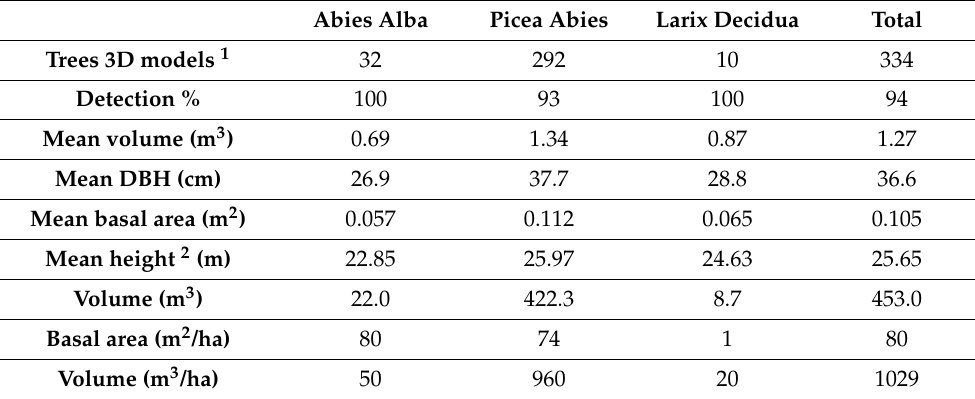
Table 2. Forest stand information of the harvesting area determined by combined TLS-UAV